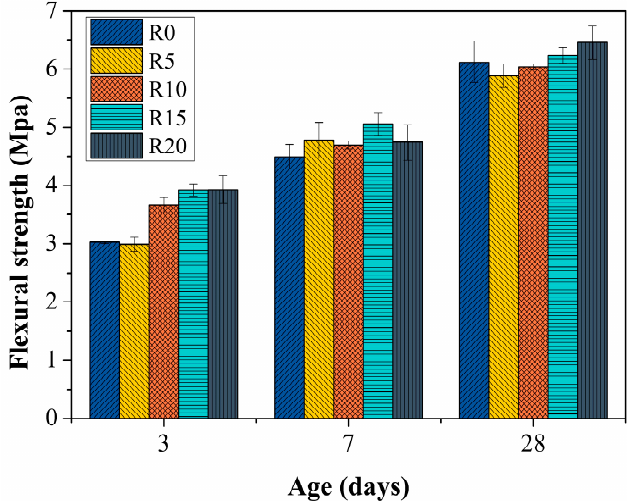
Figure 11. Flexural strength of mortars.